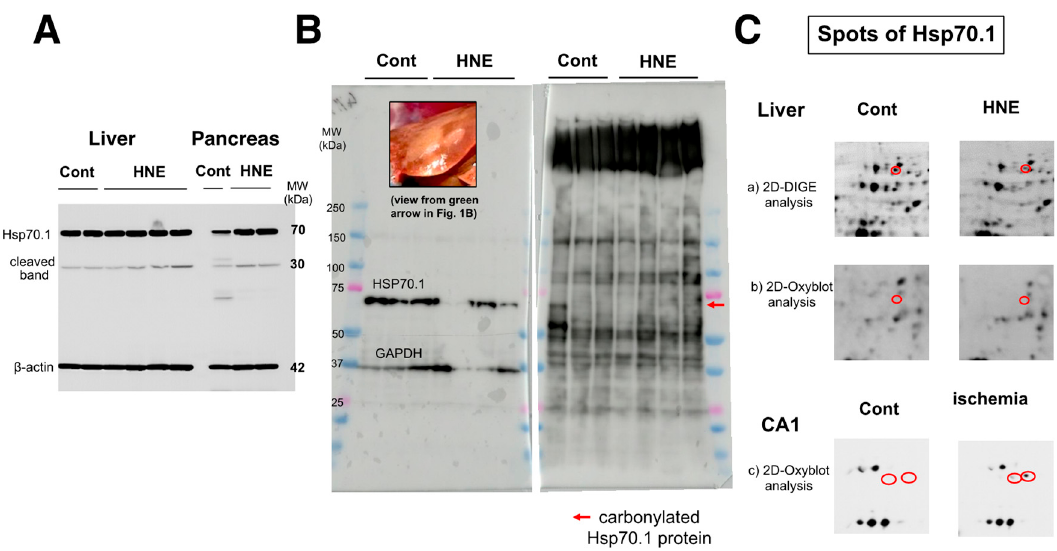
Figure 4. Western blotting ( A , B , left ), SDS-PAGE ( B , right ), and proteomics analyses ( C ) of Hsp70.1. Via Western blotting after electrophoresis on the same gel, in both the liver (dark-brown portion) and pancreas, Hsp70.1 cleavage was increased after hydroxynonenal injections ( A , HNE), compared to the control ( A , Cont). Despite being a stress-inducible protein, Hsp70.1 exhibited no upregulation of the naïve protein as a result of a long-term insult via consecutive hydroxynonenal injections in the liver ( A , liver). This was in marked contrast to the pancreas, which exhibited upregulation of Hsp70.1 naïve proteins after the same insult ( A , pancreas). Western blotting using the whitish-yellow portion showed downregulation of Hsp70.1 after hydroxynonenal injections ( B , left). SDS-PAGE using the whitish-yellow portion (Figure 1B HNE, green arrow; B , left, upper) and anti-DNP antibody showed the negligible expression of carbonylated Hsp70.1 ( B , HNE). These were consistent with the data from the 2D-Oxyblot analysis using the anti-DNP antibody, which showed the negligible expression of carbonylated Hsp70.1 ( C-b ), although 2D-DIGE showed the decreased expression of Hsp70.1 after the hydroxynonenal injections ( C-a ). The reduction in carbonylated Hsp70.1 after consecutive hydroxynonenal injections was in marked contrast to the significant increase in carbonylated Hsp70.1 in the hippocampal CA1 after transient ischemia ( C-c ) [35].